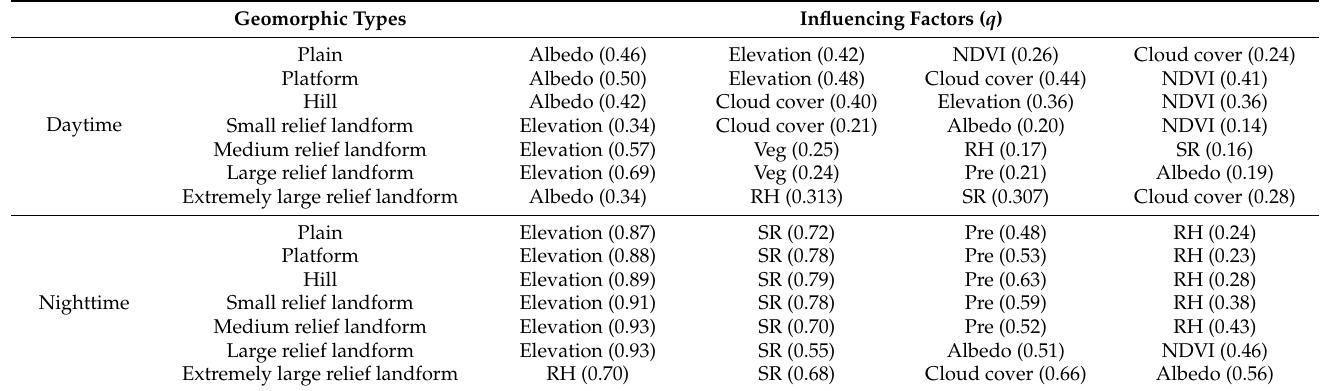
Table 3. Main influencing factors and corresponding q values in different geomorphic types for daytime and nighttime LST.